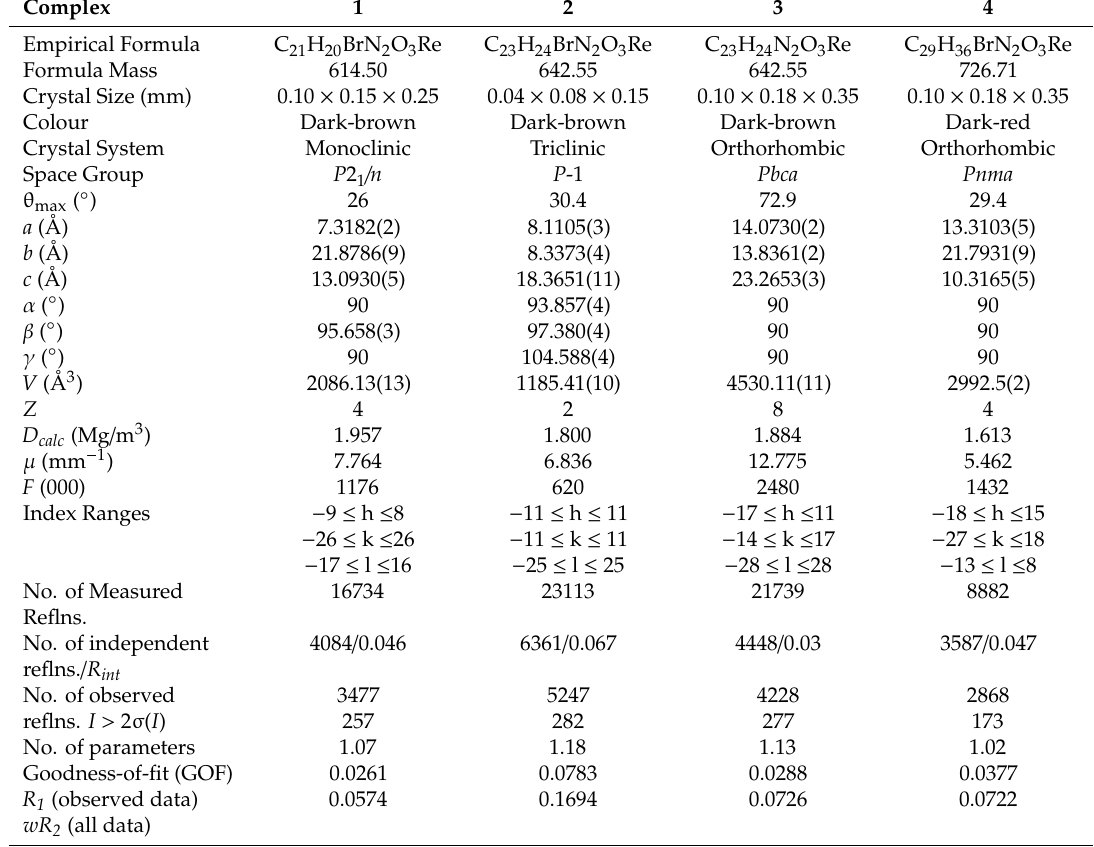
Figure 1. The molecular structure of complexes 1 – 4 , showing 40% probability displacement ellipsoids and the atomic numbering (H atoms are shown as blue wire). The symmetry code for unlabeled atoms in 4 is x, -y + 1 / 2, z. Table 1. Crystal data and refinement parameters of complexes 1–4.